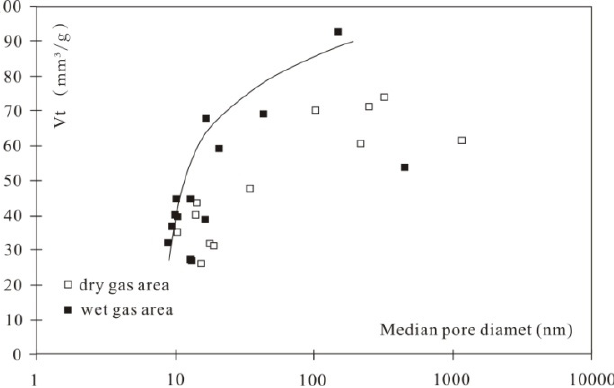
Figure 7. Relationship between total pore volume and median pore diameter (Lan et al., 2020).